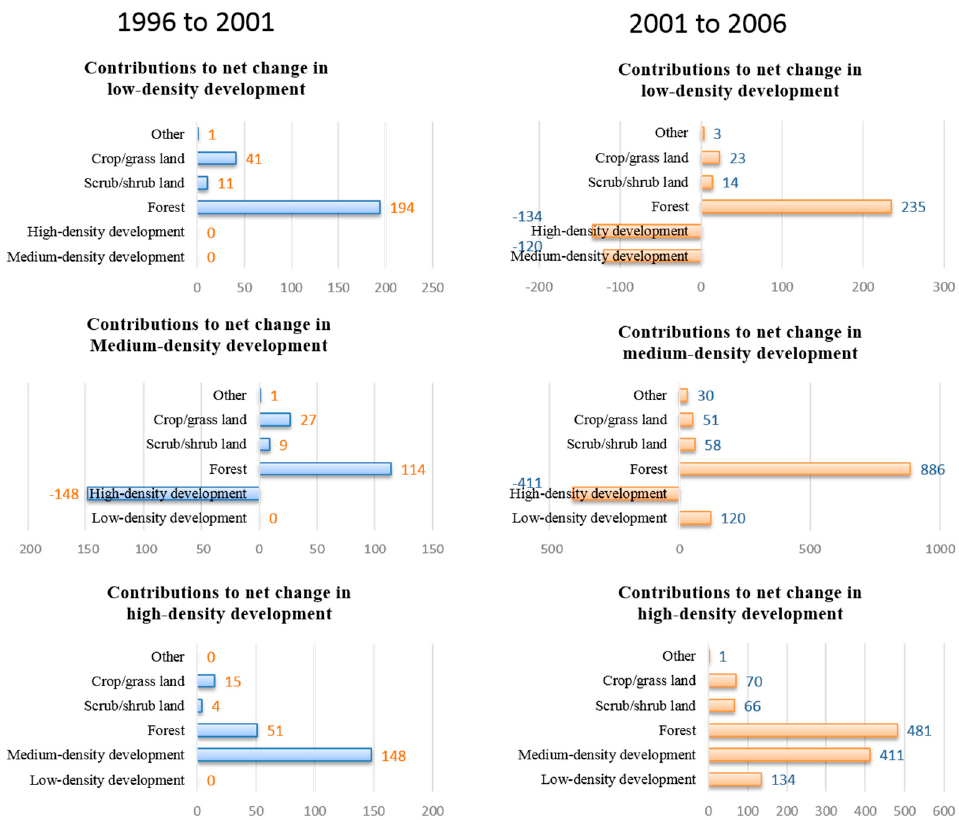
Figure 4. Contributions of land cover/use classes to net changes of developed areas at different density levels (Left column (light blue bars) shows the contributions to net change from 1996 to 2001, and right column (light orange bars) shows the contributions to net change from 2001 to 2006). Table 3. Quantities of land cover/use changes over time in terms of hectare and percentage of each class.